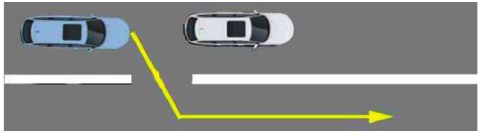
Figure 3: Schematic diagram of vehicle changing lanes (picture from the